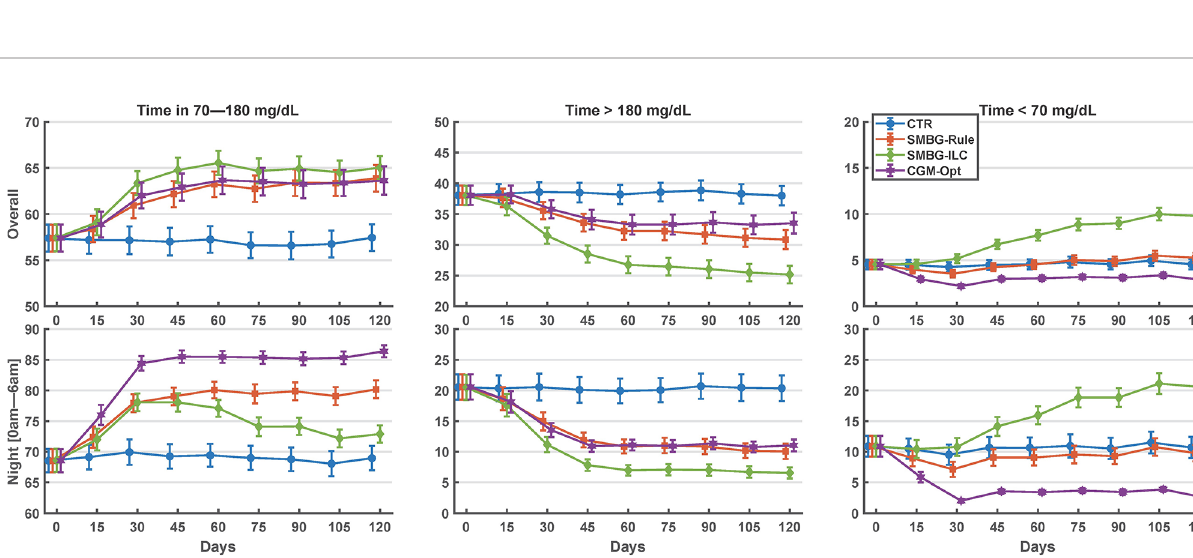
FIGURE 2 | Summary of glycemic outcomes in every 15 days period for the variance scenario of the in-silico experiment. Values are shown as mean and standard